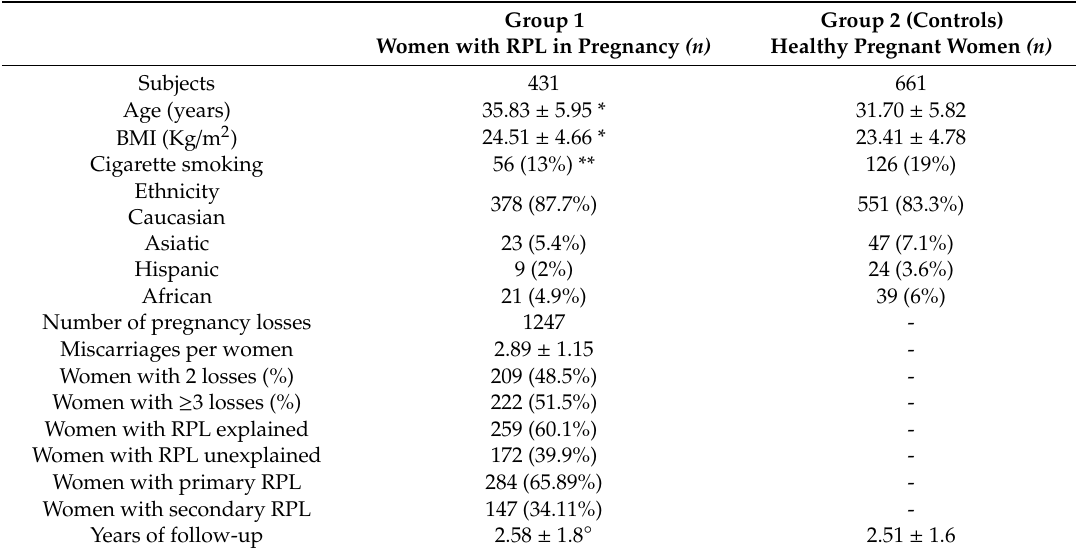
Table 2. General characteristics of study